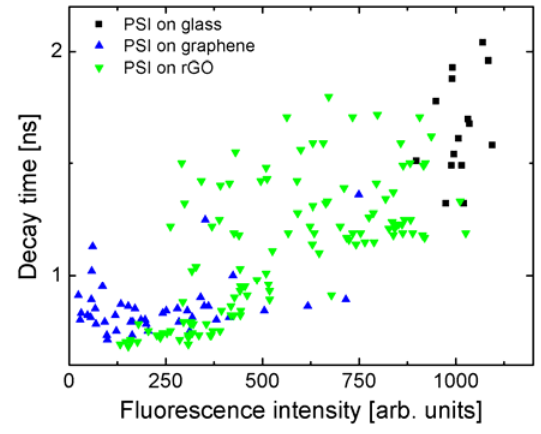
Figure 5. Correlation plot displaying the relation between integrated fluorescence intensity and the decay time, for PSI complexes deposited on glass (black squares), monolayer graphene (blue triangles), and rGO (green triangles) substrates.